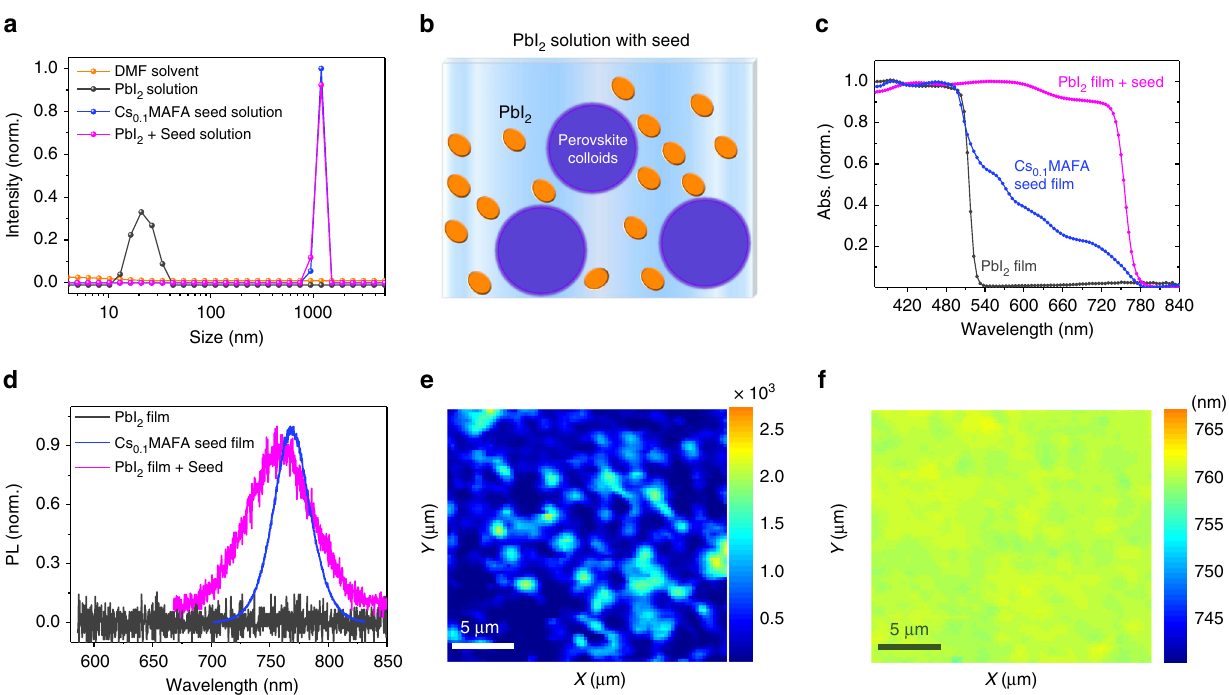
Fig. 2 Optical characterization of the PbI 2 fi lm with perovskite seeds. a Dynamic light scattering spectra of the pure PbI 2 solution (0.00028 M), pure perovskite precursor solution (0.00028 M), and the PbI 2 solution mixed with perovskite precursor solution (0.00028 M for PbI 2 and 0.00004 M for perovskite precursor). The size indicates the colloidal particle size in solution. b Illustration of the colloids of perovskite precursor in PbI 2 solution. c , d The absorption and PL spectra of pure PbI 2 fi lm, perovskite seed fi lm with a composition of Cs 0.10 FA 0.78 MA 0.12 PbI 2.55 Br 0.45 , and PbI 2 fi lm with perovskite seeds (seed concentration 14 vol.%). e – f Confocal PL mapping of the intensity ( e ) and peak position ( f ) on the PbI 2 fi lm with perovskite